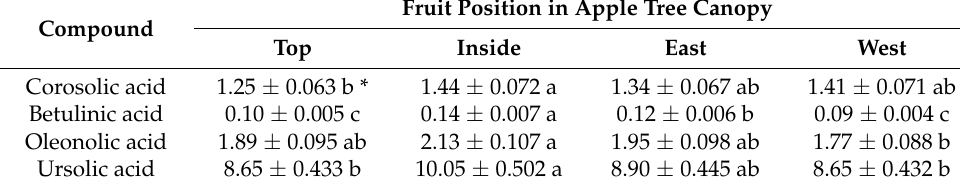
Table 9. Effect of canopy position on triterpene composition in apple peel, mg g − 1 DW,